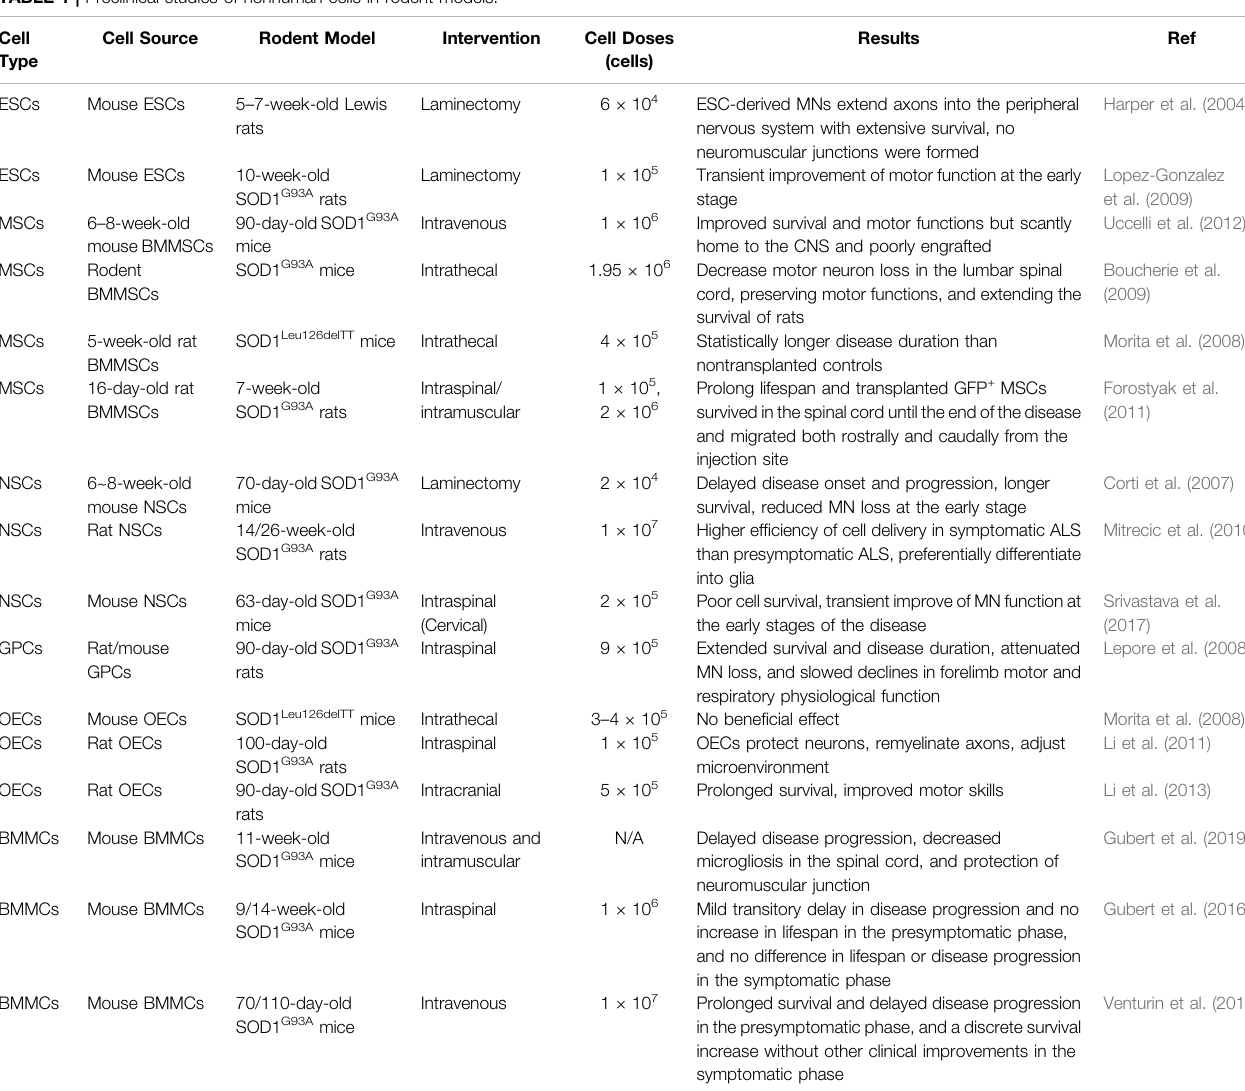
TABLE 1 | Preclinical studies of nonhuman cells in rodent